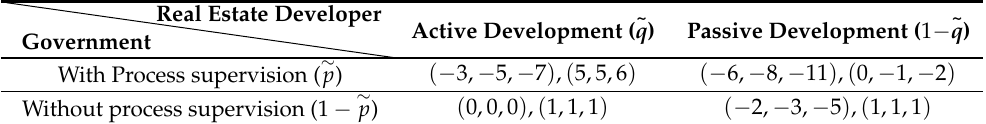
Table 4. Triangular fuzzy profit and loss value matrix of mixed strategy game between government and real estate